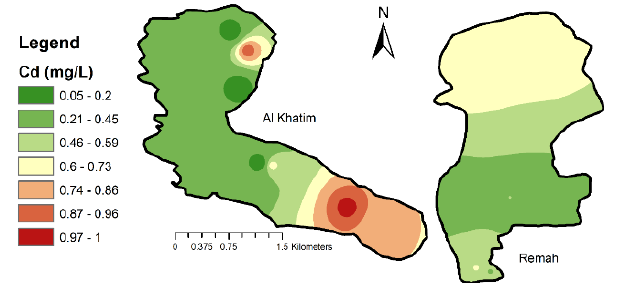
Figure 10. Spatial distribution of cadmium ion.